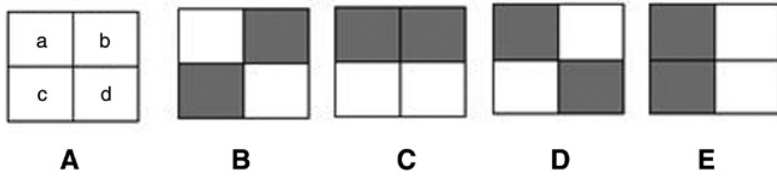
Figure 2: Four Texton Types Defined in